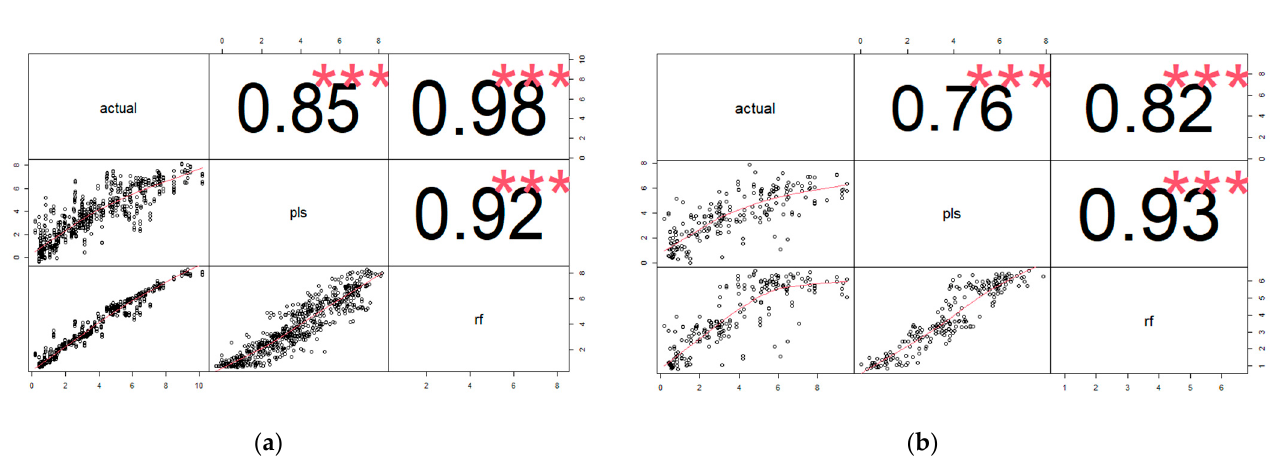
Figure 3 . Correlation between actual and predicted iCheck TCC values using PLS and RF calibration models in the training ( a ) and validation sets ( b ).